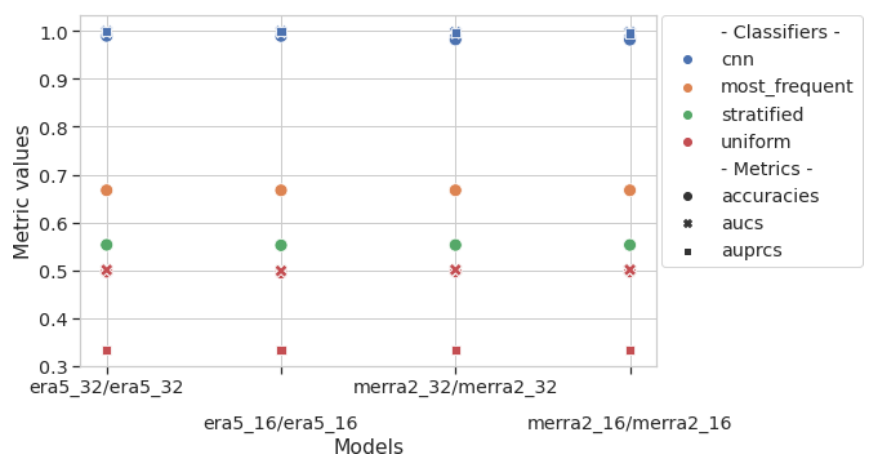
Figure 7. Metric values showing the performances of the CNN versus simple classifiers for the four datasets. The color of the symbols corresponds to the classifiers, while the marker shapes indicate the nature of the metric. The models are tested against the same image set as they are trained against (e.g., era5_32/era5_32 means the CNN was trained and tested on ERA5